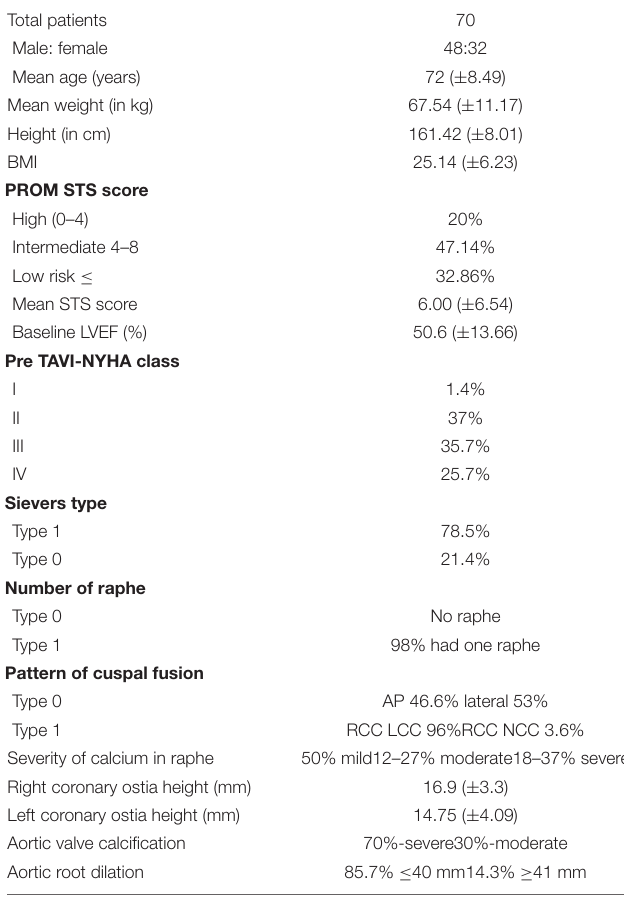
TABLE 1 | Base line characteristics of bicuspid aortic valve patients in the